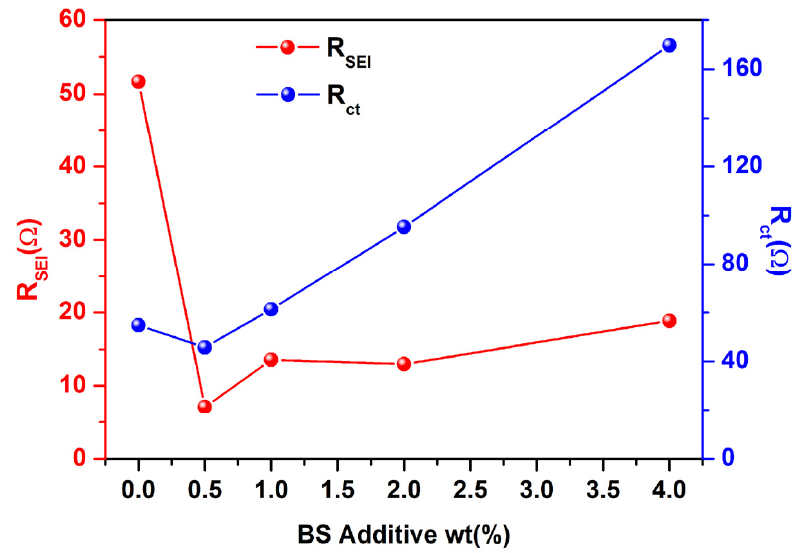
Figure 3. EIS parameters of LTO electrodes, with and without BS additive.